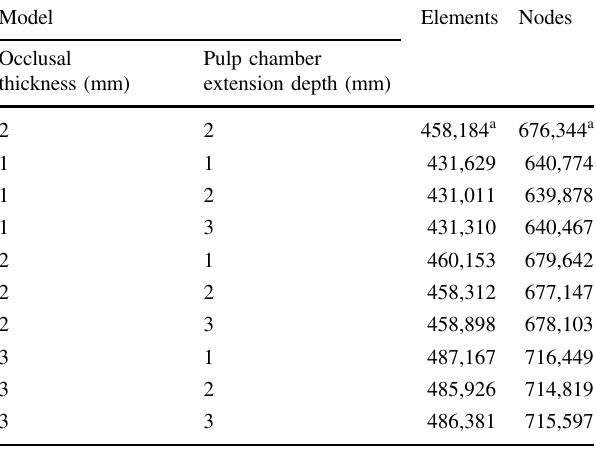
Table 2 Element numbers and node numbers for the models in this study Model